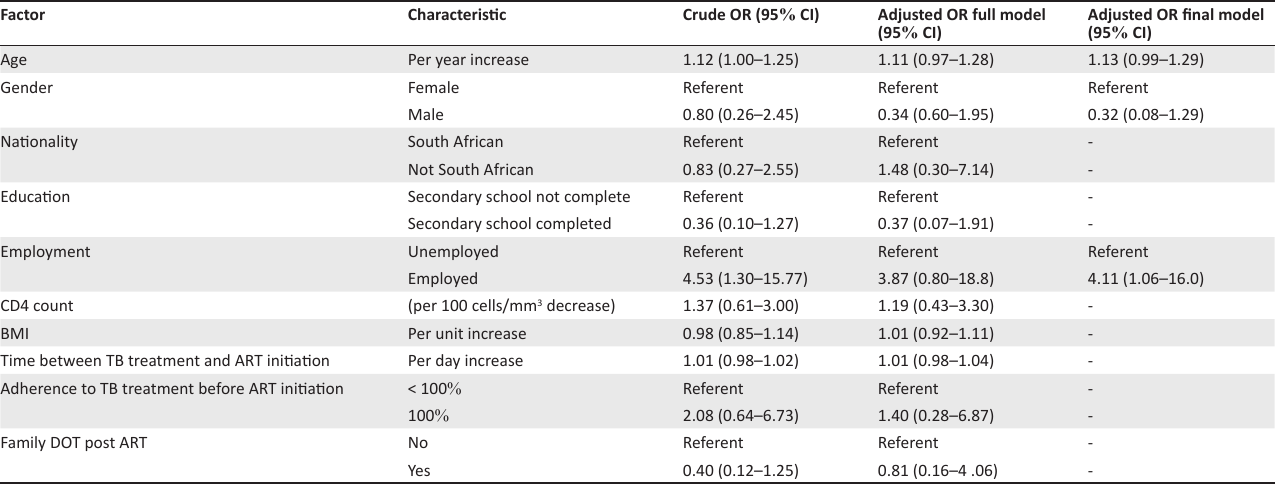
TABLE 3: Factors associated with optimal adherence (100 % of prescribed doses) following initiation of antiretroviral treatment in patients receiving treatment for active tuberculosis (pe 0.05; pr 0.15).